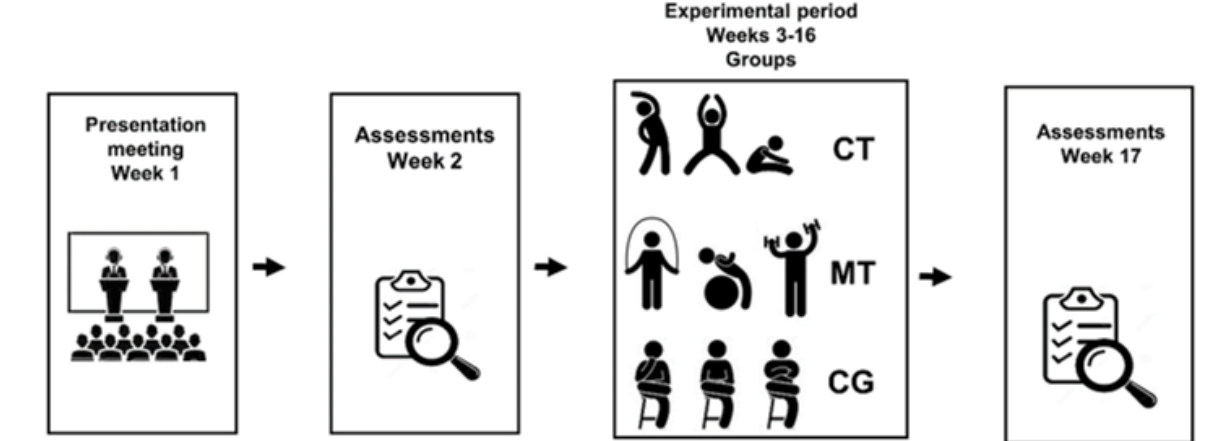
Figure 1. Study design. Abbreviations: CT; combined training; CG, control group; MT, multicomponent training.